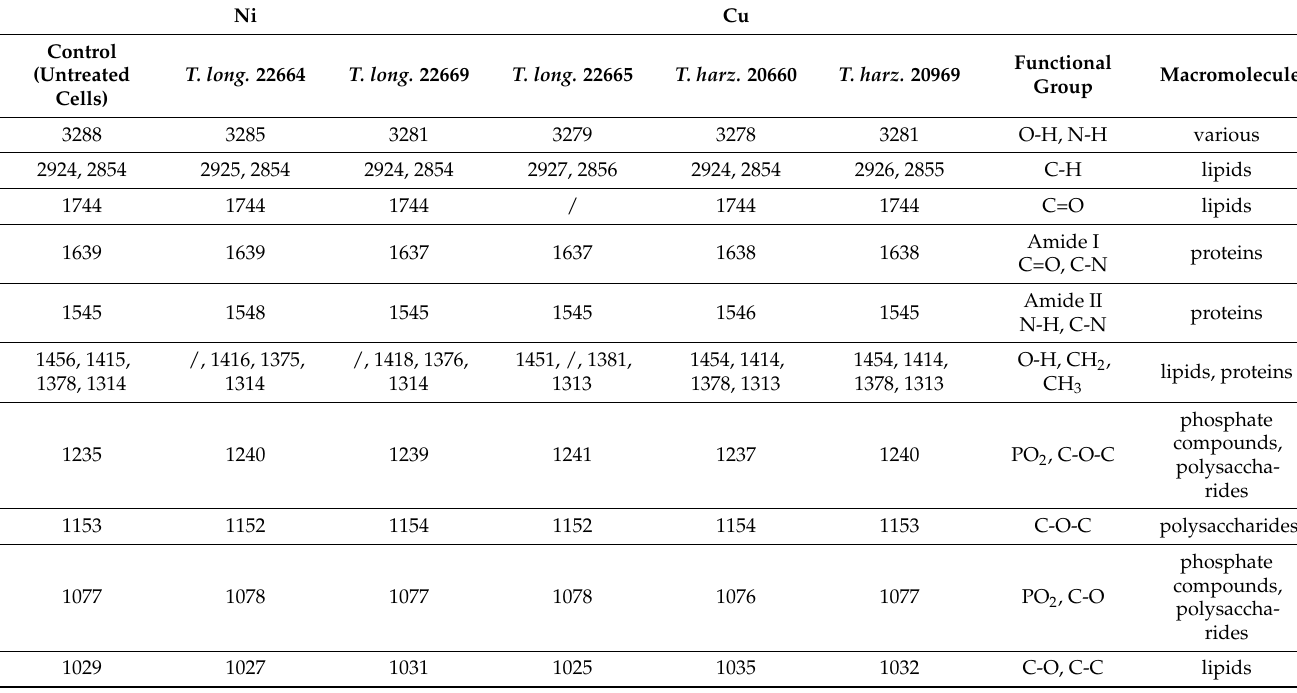
Table 4. Wavenumbers (cm − 1 ) and assignments of FTIR bands for Trichoderma fungal cells grown on clear PDA (control) and the PDA containing 60 mg/L Ni or Cu